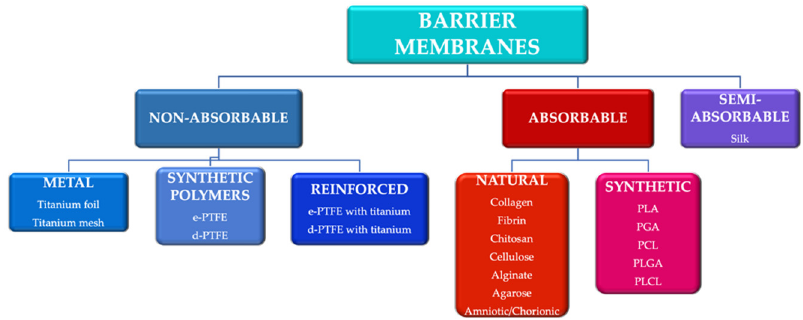
Figure 1. Main categories of barrier membranes used in guided tissue regeneration. e-PTFE: expanded polytetrafluoroethylene; d-PTFE: high density polytetrafluoroethylene; PLA: polylactic acid; PGA: polyglactic acid; PCL: polycaprolactone; PLGA: poly-lactic-co-glycolic acid PLCL: poly-lactic-co-caprolactone acid.